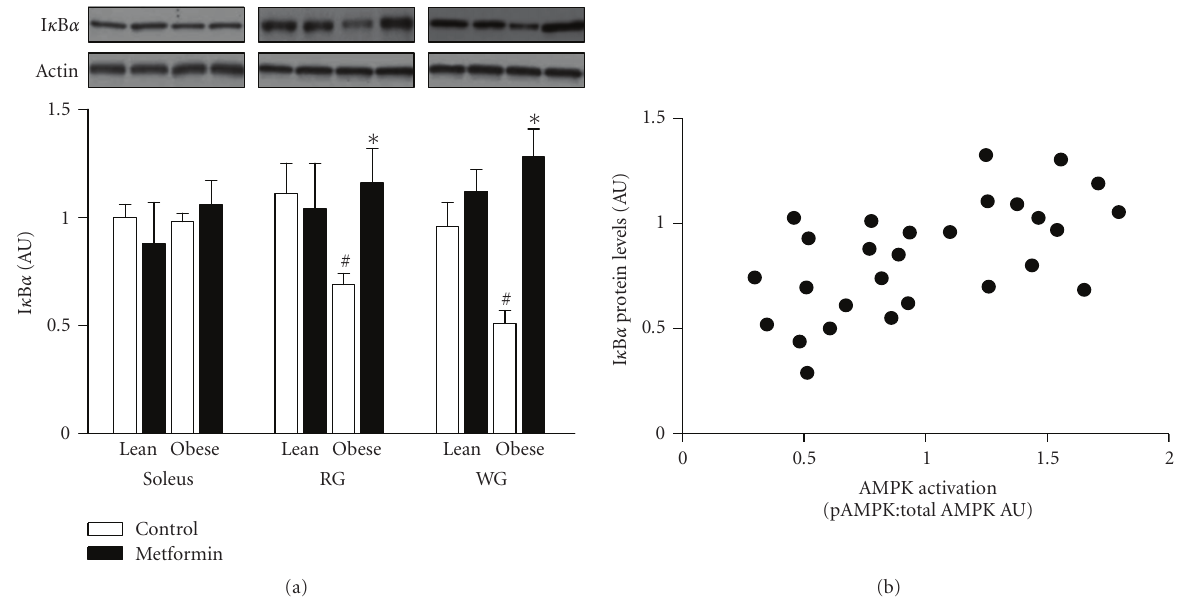
Figure 2: The e ff ect of vehicle (open bars) or metformin (filled bars) on I κ B α levels in soleus, RG, and WG (a) and the correlation between AMPK and I κ B α (b) in WG from obese and lean male Zucker rats. Equal loading of proteins was ensured by probing for actin. P < . 05 for vehicle versus metformin treatment within same phenotype ( ∗ ) and lean versus obese within a given treatment (#). AMPK activation and I κ B α levels were significantly correlated in WG ( r = 0 . 755, P < .